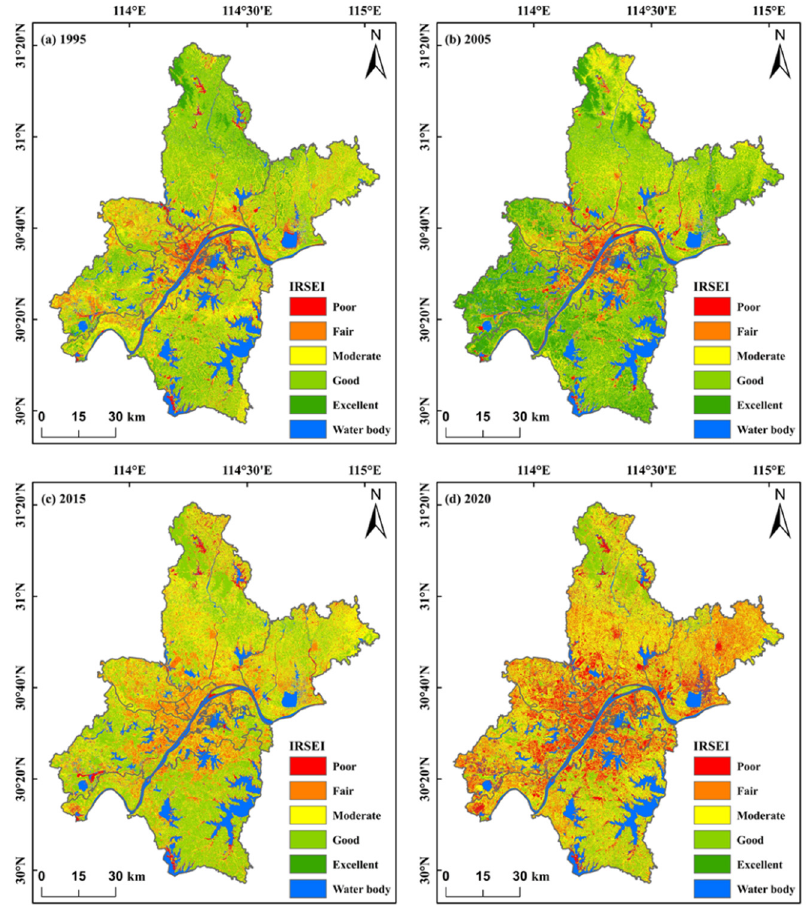
Figure 6. Grading map of UEQ from 1995 to 2020 in Wuhan city. ( a ) IRSEI 1995, ( b ) IRSEI 2005, ( c ) IRSEI 2015 and ( d ) IRSEI 2020. Table 6. Area statistics of UEQ evaluation grade from 1995 to 2020 in Wuhan city (unit: km 2 , %).